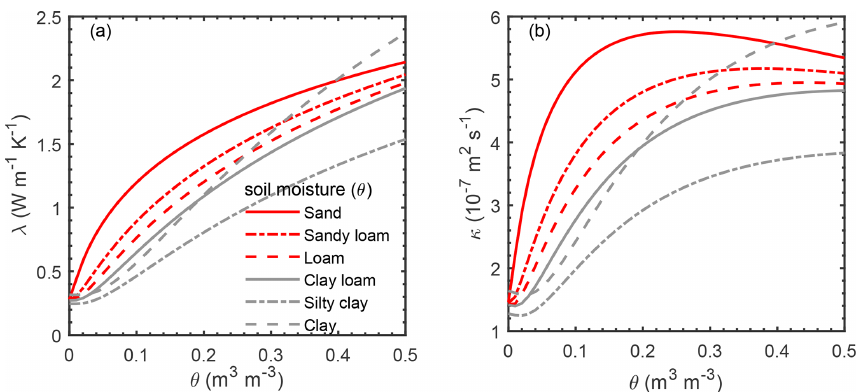
Figure 2. Effects of soil moisture on (a) thermal conductivity ( λ ) and (b) soil thermal diffusivity ( k ), as obtained by Eqs.